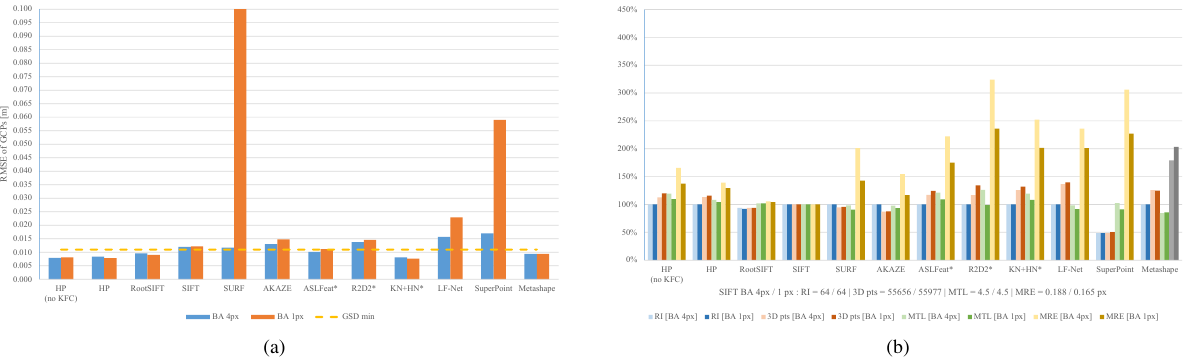
Figure 7. Ventimiglia Theatre Nadiral+Oblique dataset: (a) RMSEs of the CPs and (b) BA statistics as percentages with respect to SIFT values (RADIAL camera model with PP post-refinement, mTL=3). The min GSD is reported with respect to the downsampled images. The * superscript indicates that input images were manually rotated as the considered learning-based method is not invariant to camera rotation.